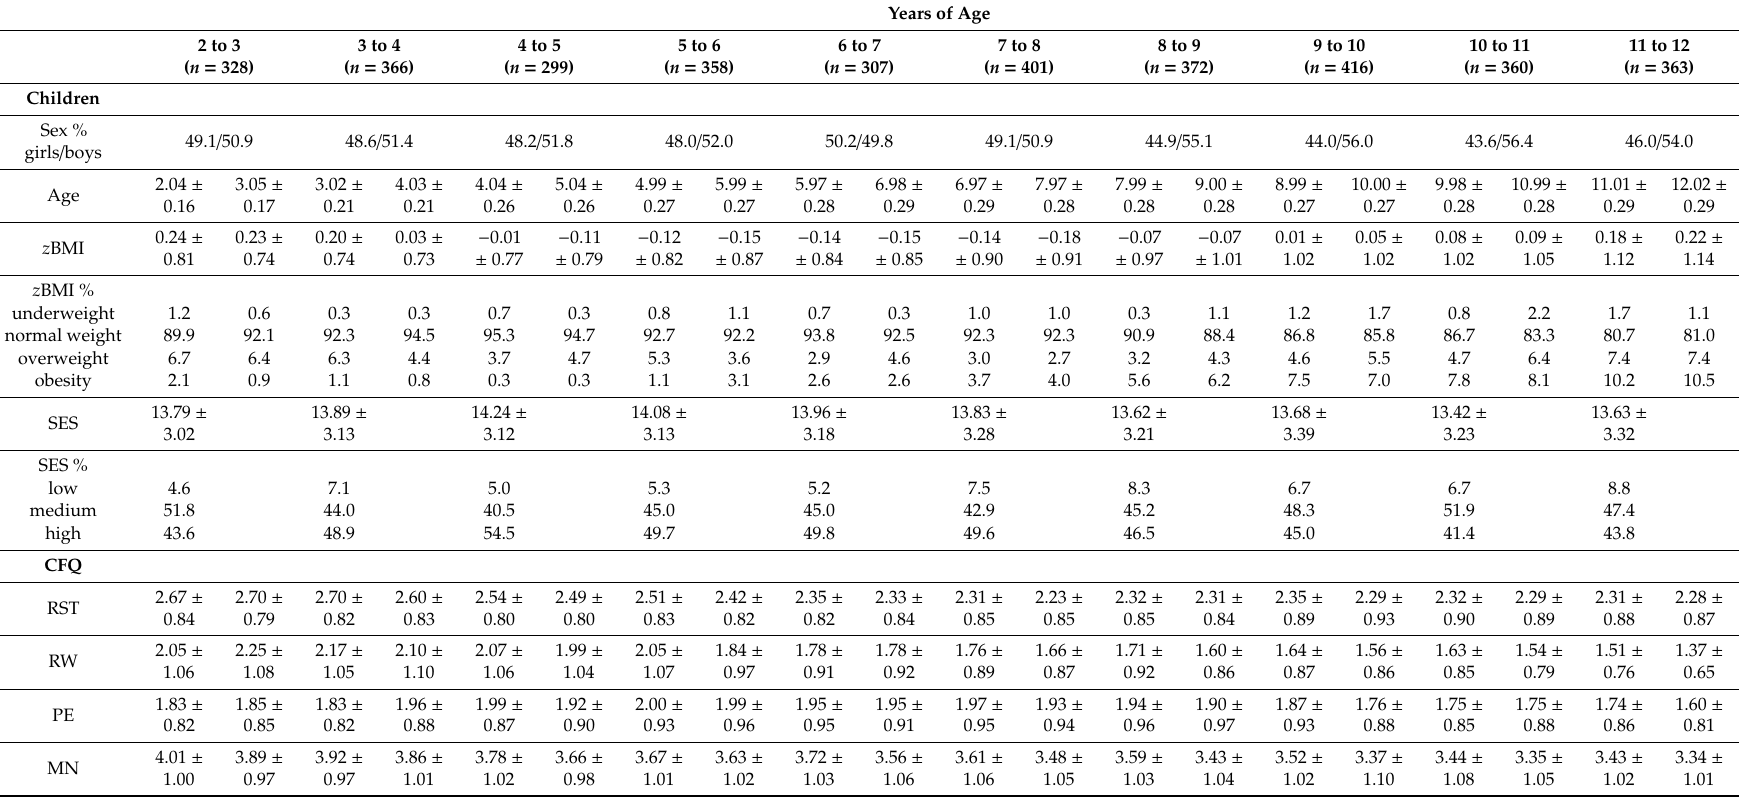
Table 1. Mean and standard deviations of sample